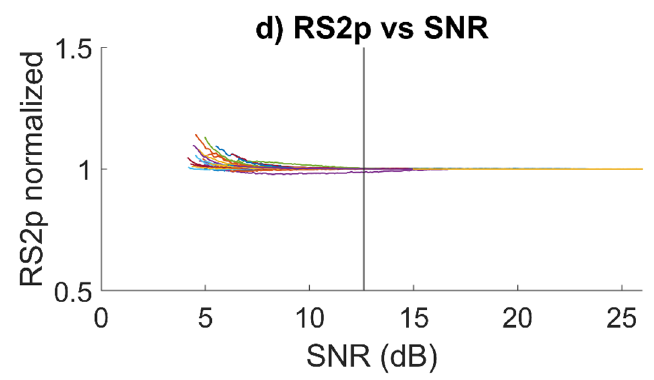
Figure 5. Plots of respectively R-S 1,M , R-S 1,T , R-S 2,A , and R-S 2,P in function of the SNR of the signal for all 25 subjects. All values were normalized with respect to the value corresponding to the highest SNR for the purposes of comparison. The black vertical lines represent the computed minimum acceptable SNR values. Each colored line represents a subject from the sample population.